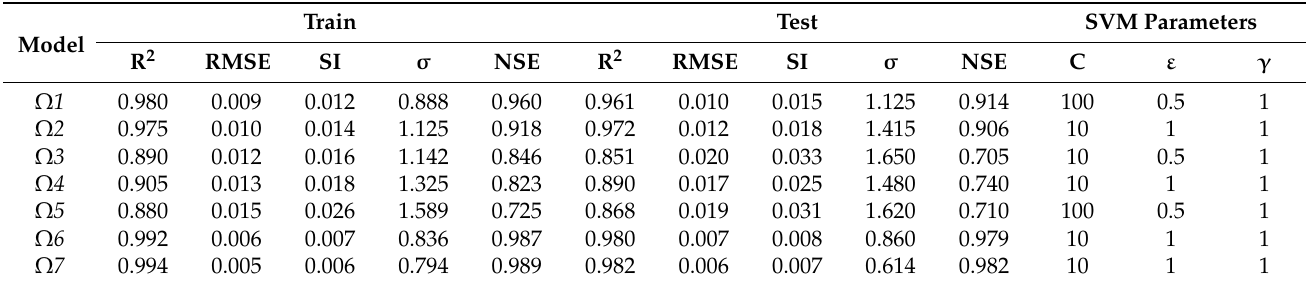
Table 8. Evaluation of hybrid models in yield estimation.